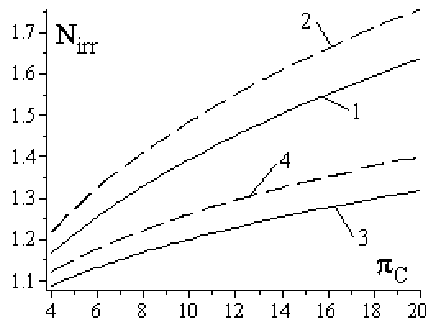
Figure 7. Dependences N irr = f N ( π C ).